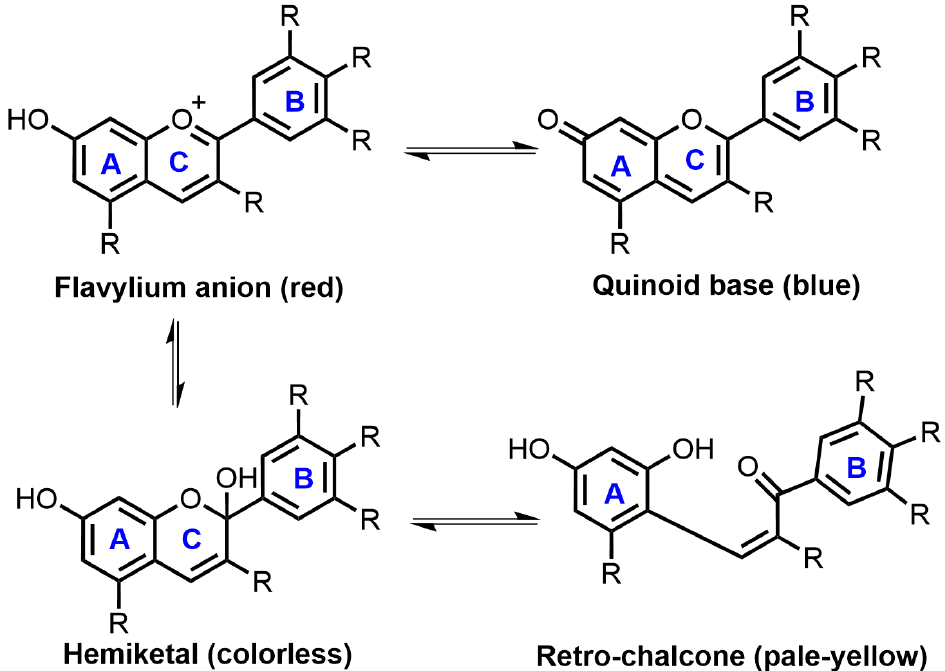
Figure 2. pH-Dependent structural isoforms of anthocyanins (A/B, aromatic rings and C, heterocyclic ring).